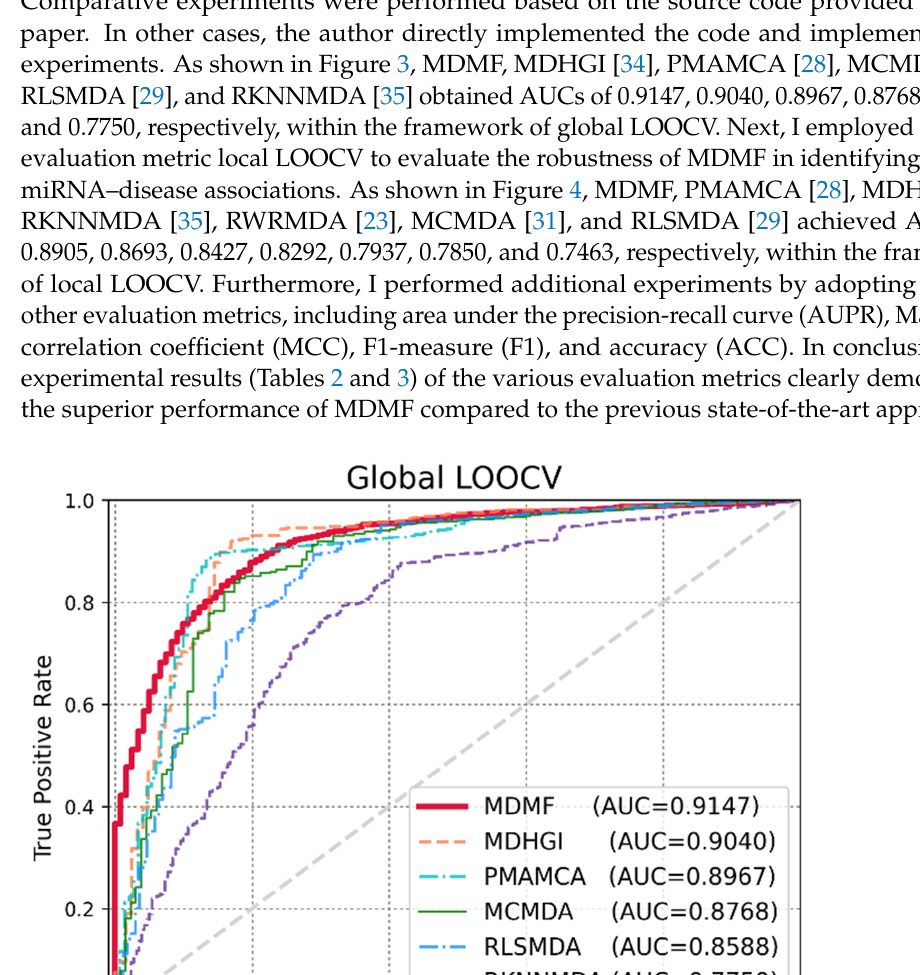
Figure 4. Performance comparisons between MDMF and six existing miRNA–disease association prediction models (PMAMCA, MDHGI, RKNNMDA, RWRMDA, MCMDA, and RLSMDA) in terms of AUCs based on local LOOCV.